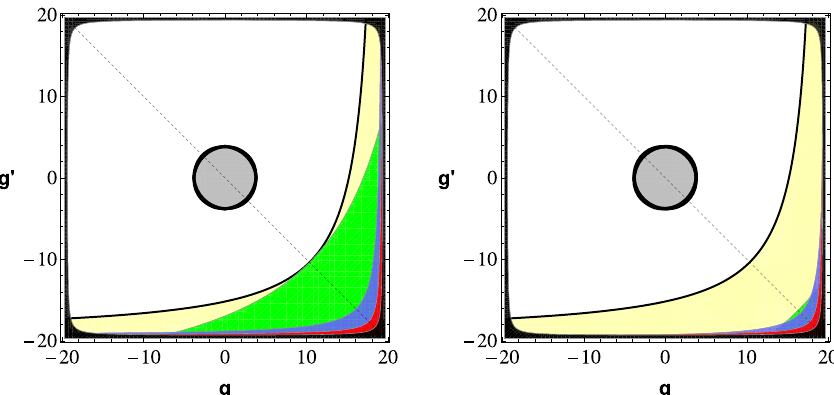
Fig. 4 Non-Markovian reactivation of quantum protocols from entanglement-breaking (here τ = 0.9 and ω = 1.02 × ω EB = 19.38). Each point of the correlation plane corresponds to a Gaussian environment with separable correlations. In the left panel we consider the optimal scenario of large μ (asymptotic protocols). Once quadripartite 1 × 3 entanglement has been reactivated (outside the grey ring), we have the progressive reactivation of entanglement swapping ( N > 0 , yellow region), quantum teleportation of coherent states ( F > 1/2, green region), entanglement/key distillation ( I C , K > 0, blue region) and practical QKD ( R > 0, red region). The right panel refers to a realistic scenario with experimentally achievable values of μ . We consider μ ≃ 6.5 (refs. 54,55 ) as input entanglement for the entanglement-based protocols, and μ ≃ 50 as modulation for the practical QKD protocol. The reactivation phenomenon persists and can be explored with current technology. Apart from teleportation, the other thresholds undergo small modi fi